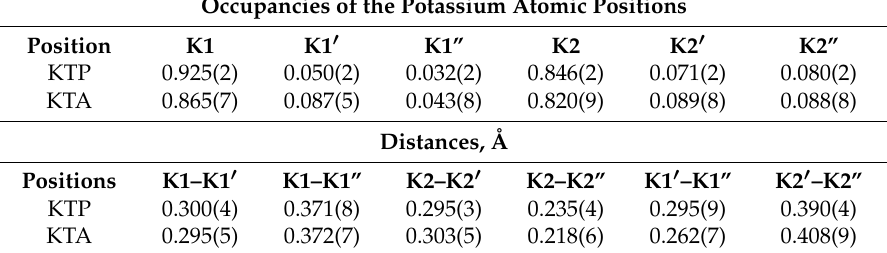
Table 3. Occupancies of potassium atomic positions and distances between these positions in the structure of KTP and KTA single